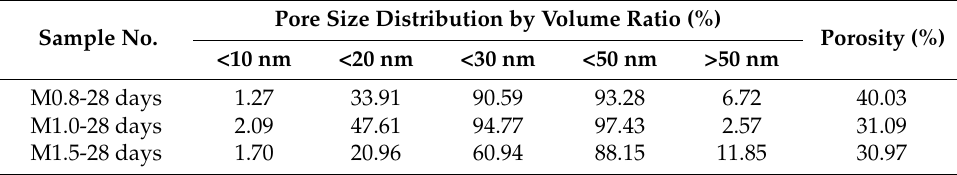
Table 3. Influence of SiO 2 /Na 2 O ratio on pore size distribution of geopolymer coating.